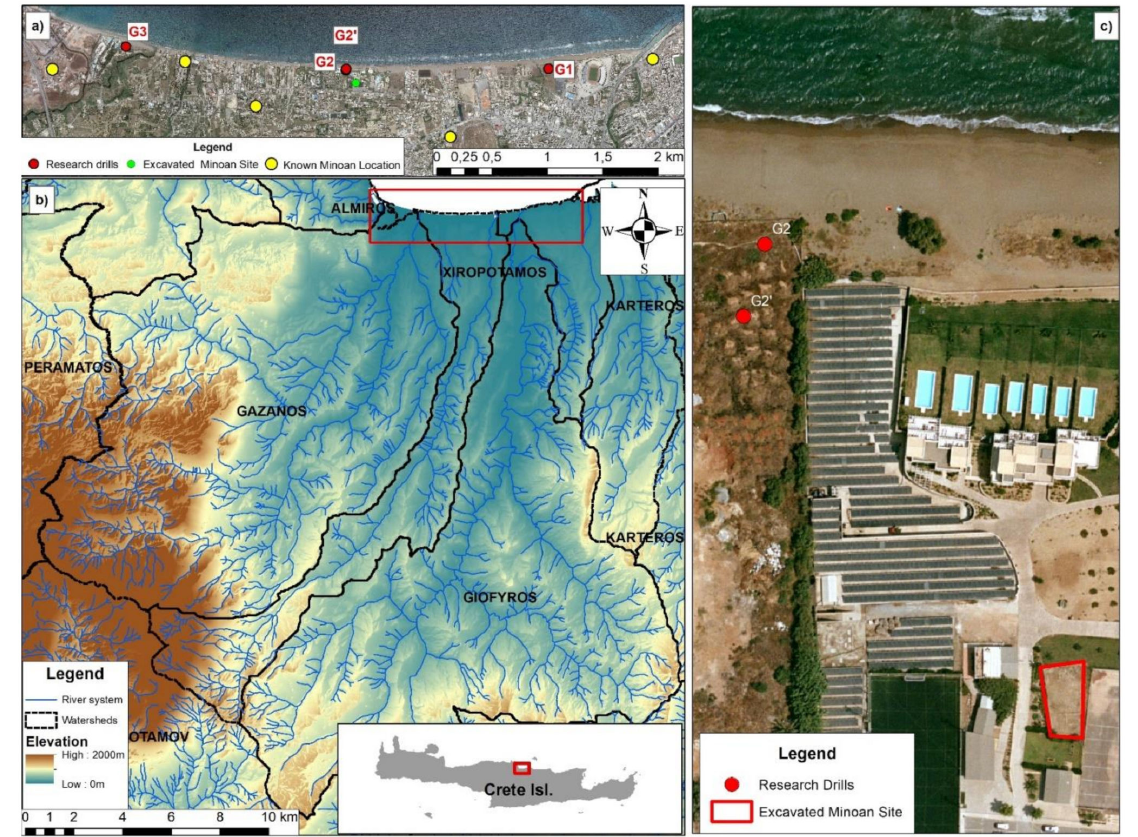
Figure 2. Location of area and hydrological basins in the study area. Known Minoan sites and research drill positions ( a ). Hydrological basins, digital image, and elevation provided by a 0.5 m DEM from Ktimatologio S.A. ( b ). Excavated Minoan site and location of G2 and G2 (cid:48) research drill positions ( c